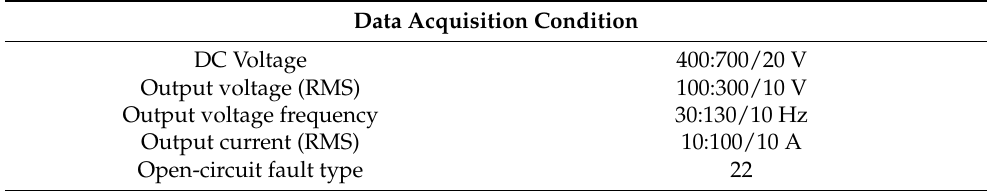
Table 2. Database acquisition process.